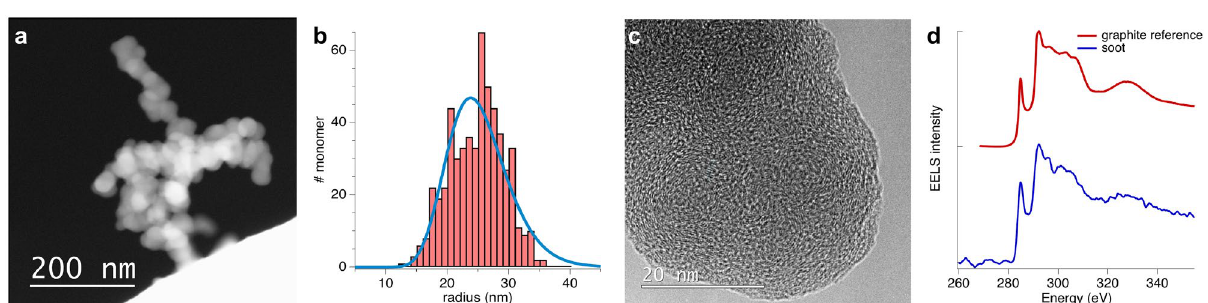
Figure 2. Microphysical properties of BC particles from a Jet-A1 pool-fire. In ( a ) is a STEM/HAADF image of a typical BC aggregate, while ( b ) shows the size distribution, in radius, of the monomers (red bars) and its lognormal fit (blue). In ( c ), a HRTEM image of a monomer is shown illustrating an onion-like structure and ( d ) presents the C–K edge EEL spectra of a monomer in blue and for graphite in red as a